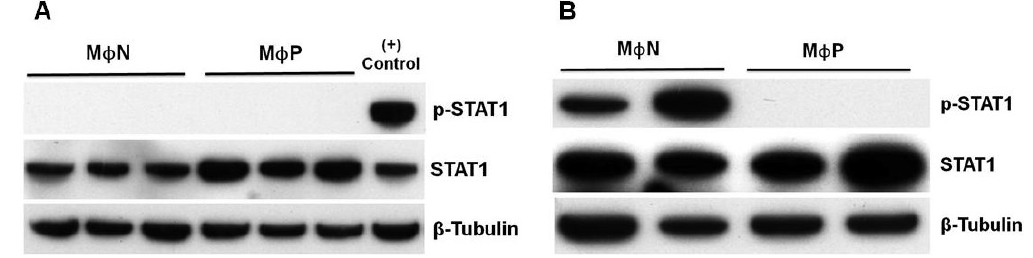
Figure 4. State of activation of transcription factor STAT1 in response to interferon-β (IFN-β) in persistently RSV-infected macrophages. ( A ) Total cell lysates of passages 95, 96 and 97 of non-infected macrophages (MΦN) and of passages 94, 95 and 96 of persistently RSV-infected macrophages (MΦP) were analyzed by western blot to detect total STAT1 and p-STAT1. As a positive control (+), MΦN were treated with 100 U/mL of recombinant-IFN-β for 45 min; ( B ) As MΦP do not respond to the IFN- β secreted by them, recombinant IFN-β (100 U/mL) was added to two passages of MΦP for 45 min. Two passages of MΦN were used as positive control. Results were reproduced in six cellular passages analyzed (biological replicates).